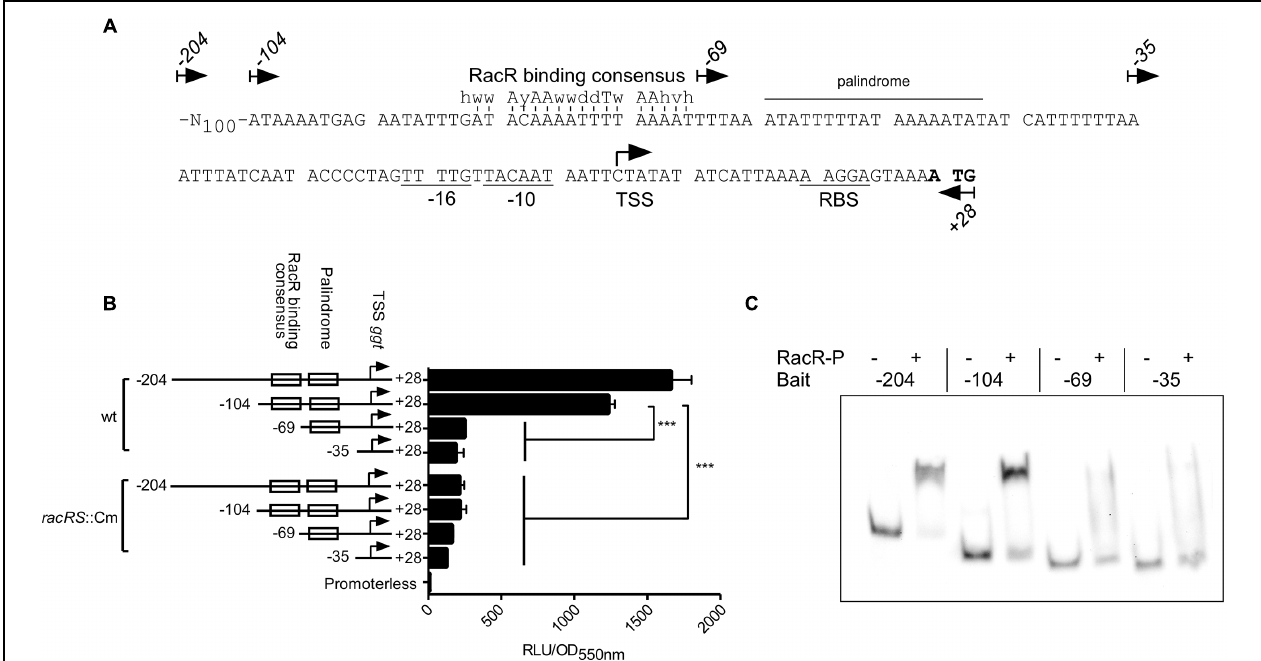
FIGURE 4 | RacR binds to a specific region on the ggt promoter. (A) Nucleotide sequence and features of the ggt promoter. The start codon ATG is indicated in bold face, the putative − 10 and − 16 regions and ribosomal binding site (RBS) are underlined. A palindromic sequence is indicated with a horizontal bar. The previously identified RacR binding consensus sequence (van der Stel et al., 2015) is indicated above the predicted RacR binding site, vertical lines indicate matching nucleotides. Arrows indicate the 5 (cid:5) termini and direction of the primers used to generate the ggt promoter elements for the luciferase reporter plasmids and EMSA